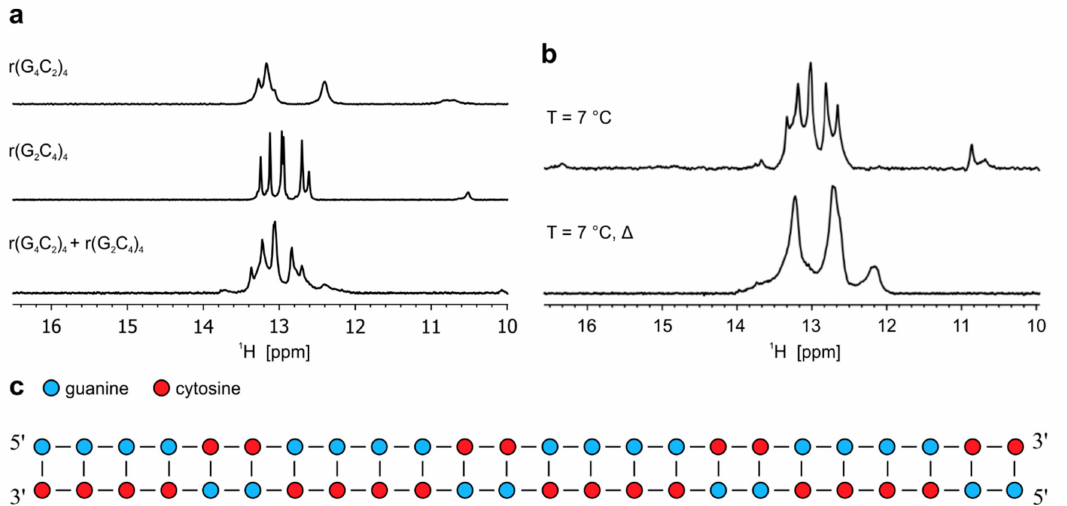
Figure 4. Formation of heterodimer by oligonucleotides r(G 4 C 2 ) 4 and r(G 2 C 4 ) 4 . ( a ) 1 H-NMR spectra of r(G 4 C 2 ) 4 , r(G 2 C 4 ) 4 and their equimolar mixture (r(G 4 C 2 ) 4 + r(G 2 C 4 ) 4 ) at pH 6.0 and 25 ◦ C. ( b ) 1 H-NMR spectra (r(G 4 C 2 ) 4 + r(G 2 C 4 ) 4 ) at 7 ◦ C before and after annealing of the sample. ∆ represents